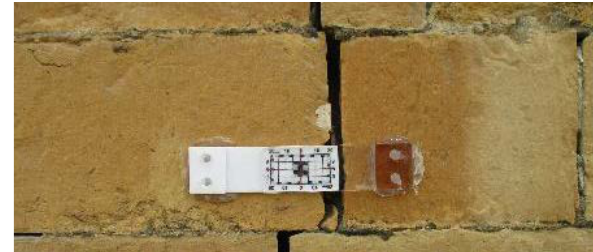
Figure 3. Installation of polycarbonate crack monitors